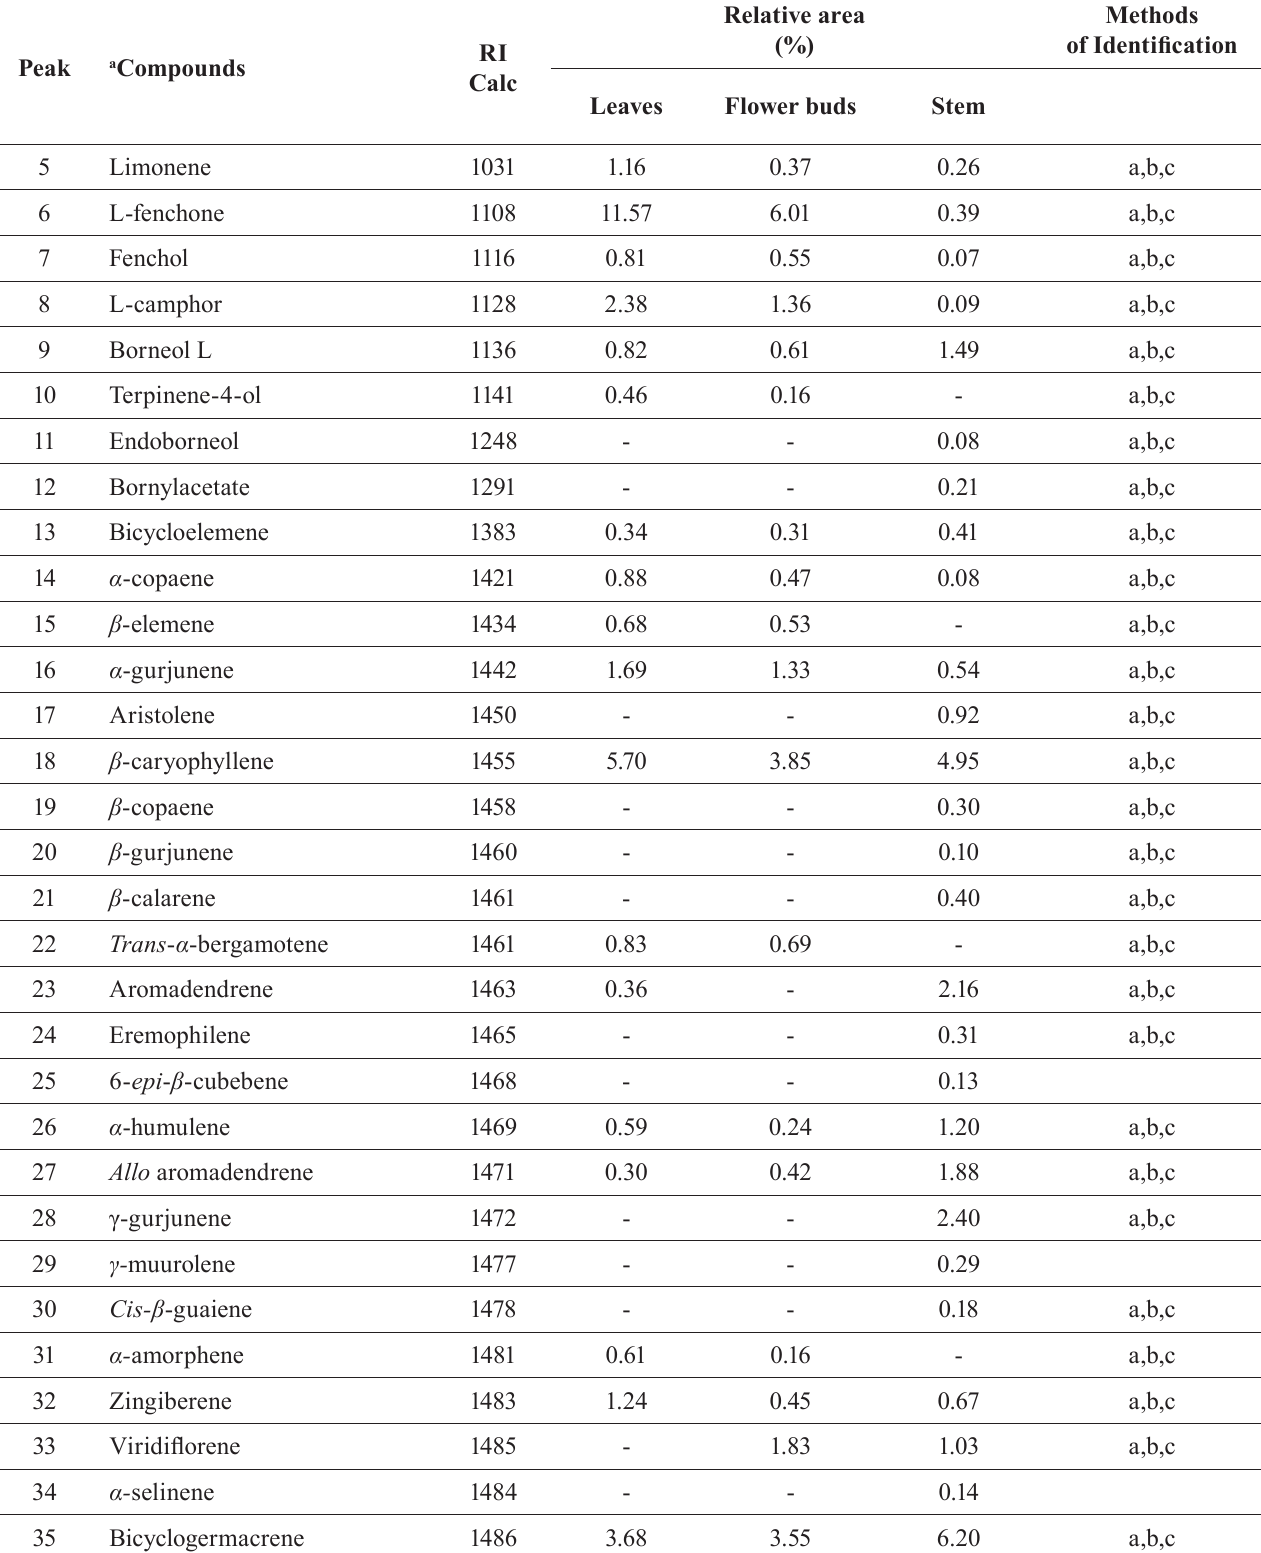
TABLE I - C hemical composition of Tetradenia riparia leaves, flower buds and stem essential oil